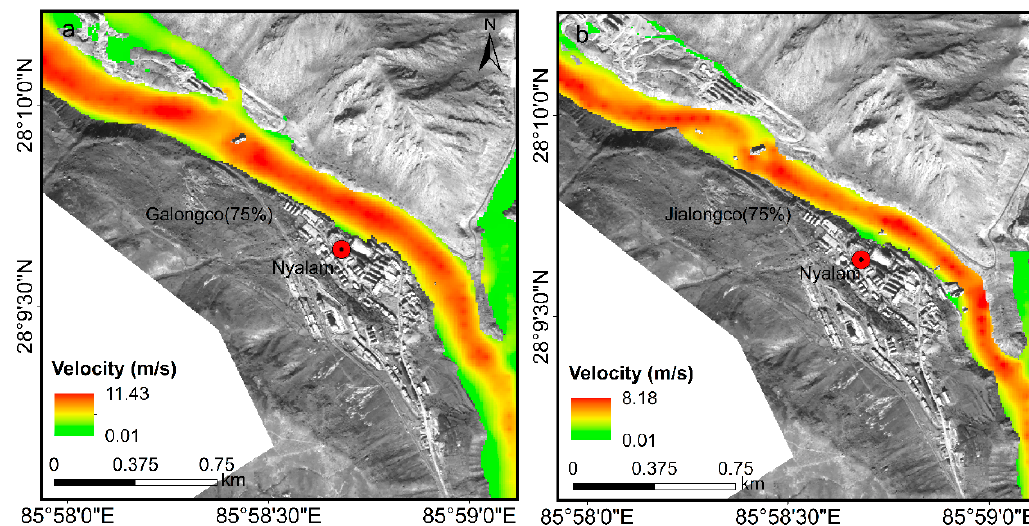
Figure 5. Velocity of GLOFs originating from ( a ) Galongco and ( b ) Jialongco under a 75% drainage scenario. Table 5. Potential impact of GLOFs from different glacial lakes on downstream villages and towns. The values are in the range of 0–1, which is calculated from the number of submerged buildings, farmland, roads, and bridges between the sections of the villages. It represents the exposure of communities and infrastructure to the risk of GLOFs.